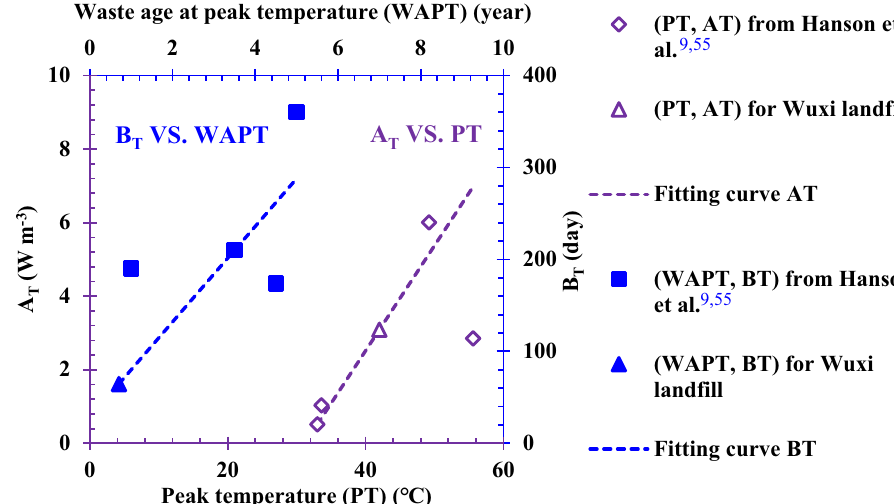
Figure 3. Method of empirical fitting for A T and B T .